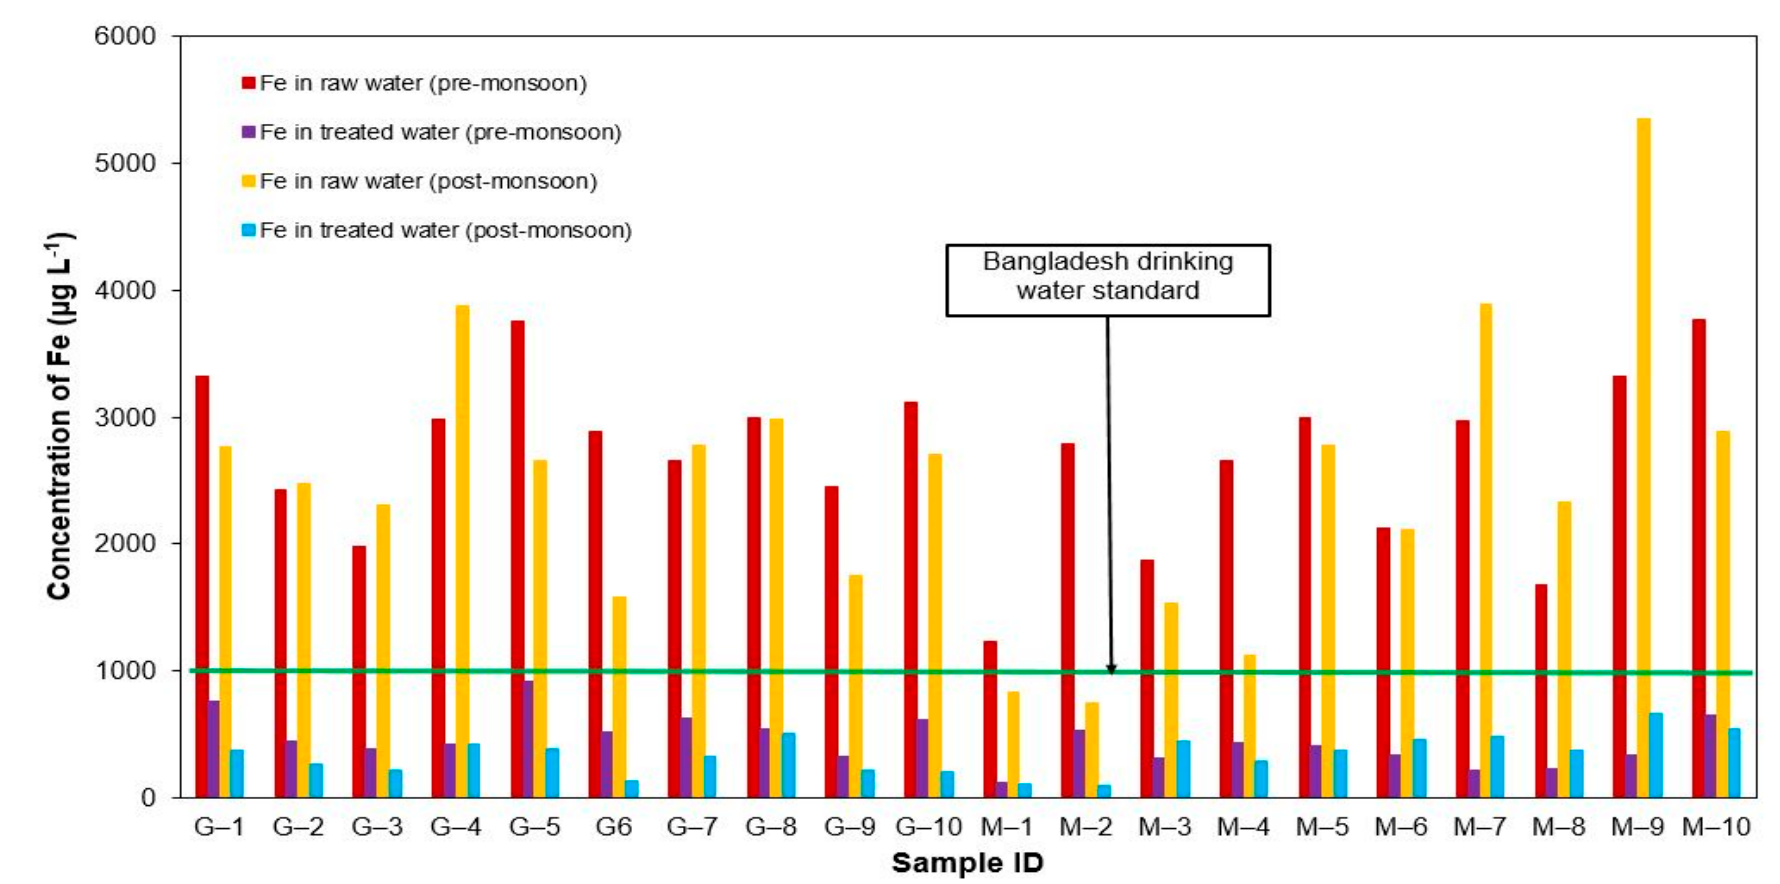
Figure 4. Concentration of Fe (µg/L) in raw and treated water during pre-monsoon and post-monsoon from rural areas in Bangladesh. The green lines indicate the standard limit of Fe in Bangladesh.